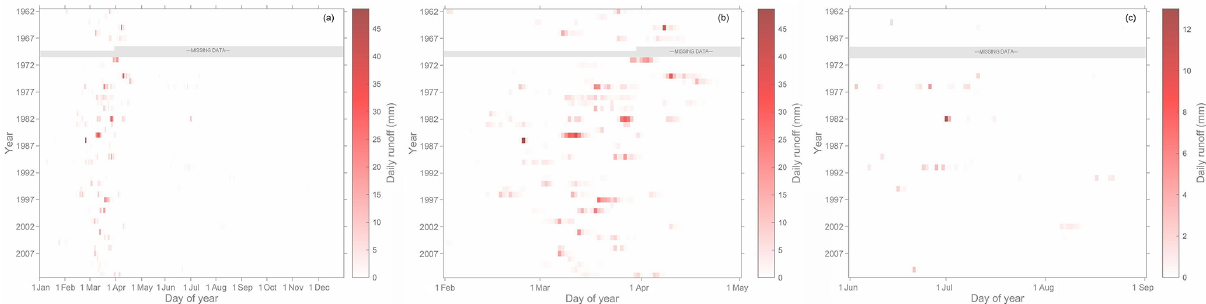
Figure 2. Daily runoff (mm) for the 50-year period on Hillslope 2. (a) shows the full calendar year for the 50-year period (1 January 1962 to 31 December 2011). (b) shows just the spring period (here, 1 February to 1 May), for increased clarity of the spring snowmelt-runoff data. (c) shows just the summer period (here, 1 June to 1 September), for increased clarity of the summer rainfall-runoff data.